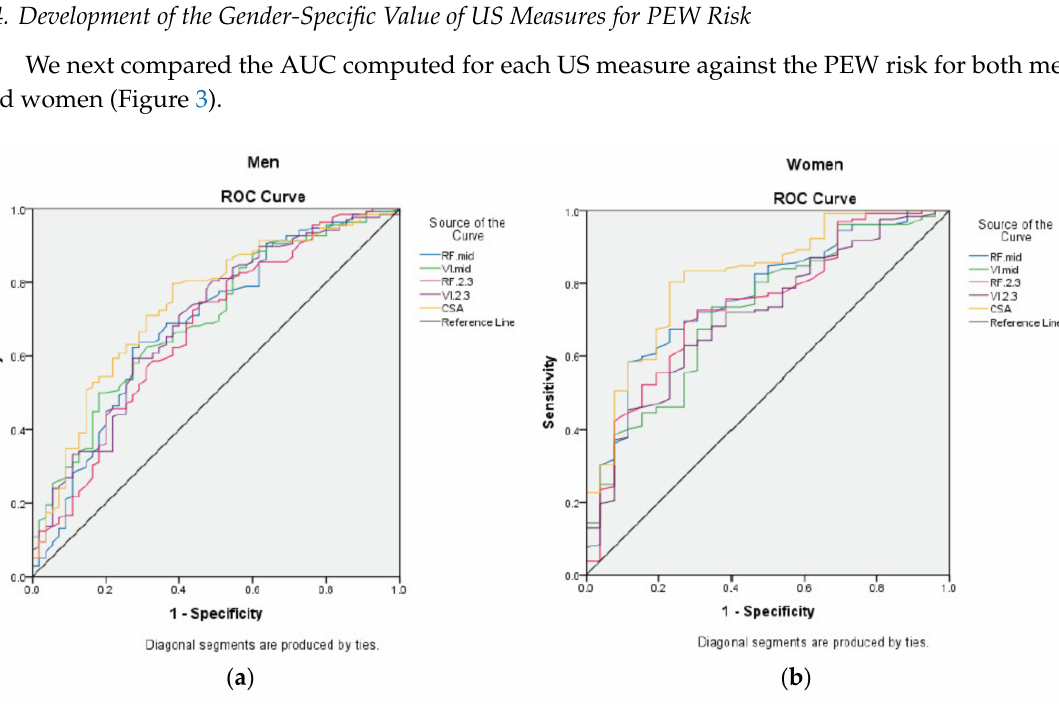
Figure 3. ROC analysis for US measures according to gender. Figure 3 represents the area under curve for riskofPEWaccordingtoUSmusclesitesfor( a )men; ( b )women. Abbreviations: CSA,cross-sectionalarea; MID, mid-point; PEW, protein energy wasting; ROC, receiver operating characteristic; RF, rectus femoris ; US, ultrasound; VI, vastus intermedius